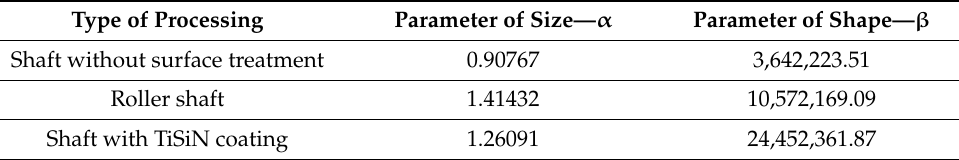
Table 6. Weibull distribution parameters.